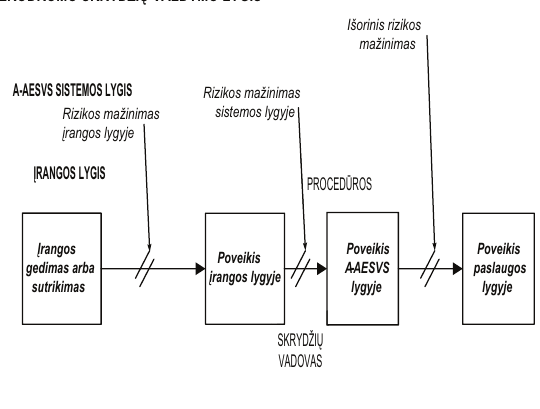
Fig. 2. Evaluated system limits